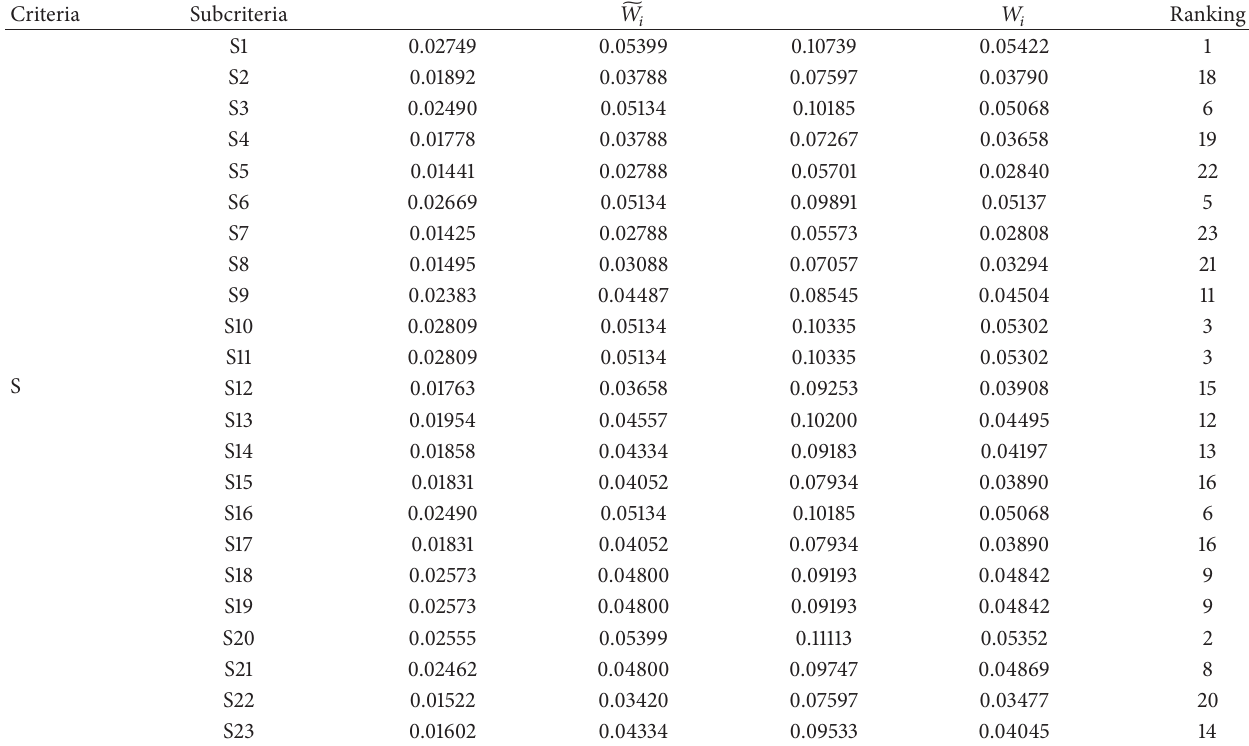
Table 14: Fuzzy and crisp weights and ranking scores for subcriteria in sensorial